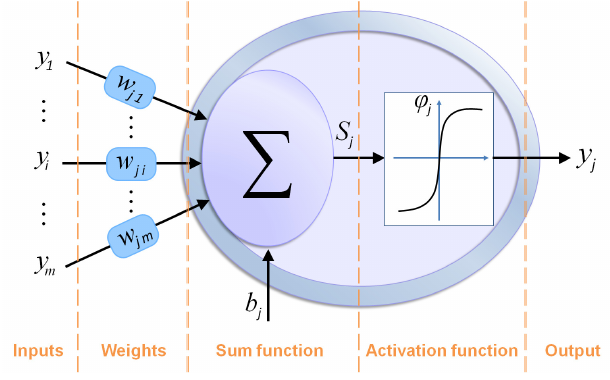
Figure 7. Basic structure of an artificial